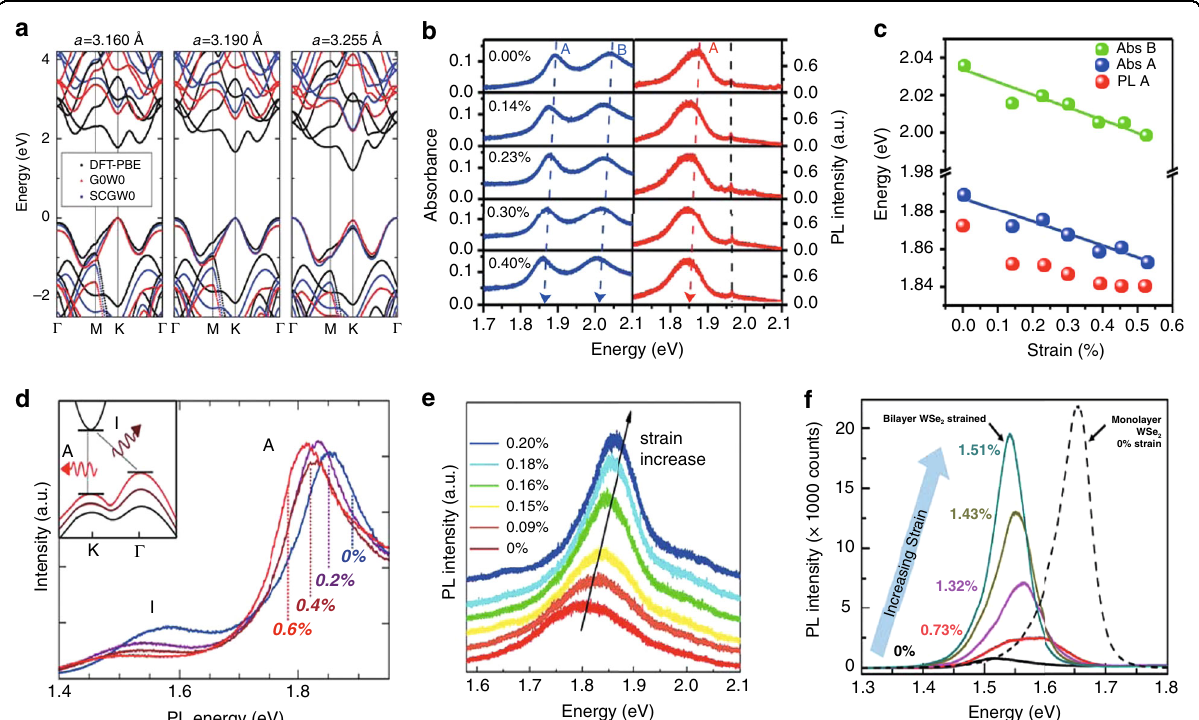
Fig. 2 Band structures and PL and absorption spectra of strained TMDCs under different strains. a Band structures of monolayer MoS 2 at lattice constant of 3.160, 3.190, and 3.225 Å corresponding to 0%, 1%, and 3% tensile strains calculated by DFT, G0W0, and SCGW0, respectively 32 . b , c Evolution of PL and absorption spectra ( b ) and peak positions ( c ) of monolayer MoS 2 under various uniaxial tensile strains. Note that the dashed black line overlaid on the PL spectra in b indicates the PL peak of PMMA rather than that of the B exciton. Lines in c are linear fi ts to the data points extracted from b 29 . d PL spectra of bilayer MoS 2 under uniaxial tensile strain increasing from 0 to 0.6%. The insert shows the indirect bandgap of bilayer MoS 2 (ref. 28 ). e PL spectra of trilayer MoS 2 under various biaxial compressive strains 76 . f PL spectra of bilayer WSe 2 (solid lines) under various uniaxial tensile strains compared with that of unstrained monolayer WSe 2 (dashed line) 78 . Reprinted a with permission from ref. 32 . Copyright (2013) by the American Physical Society. Adapted b , c with permission from ref. 29 . Copyright (2013) American Chemical Society. Adapted d with permission from ref. 28 . Copyright (2013) American Chemical Society. Adapted e with permission from ref. 76 . Copyright (2013) American Chemical Society. Reprinted f with permission from ref. 78 . Copyright (2014) American Chemical